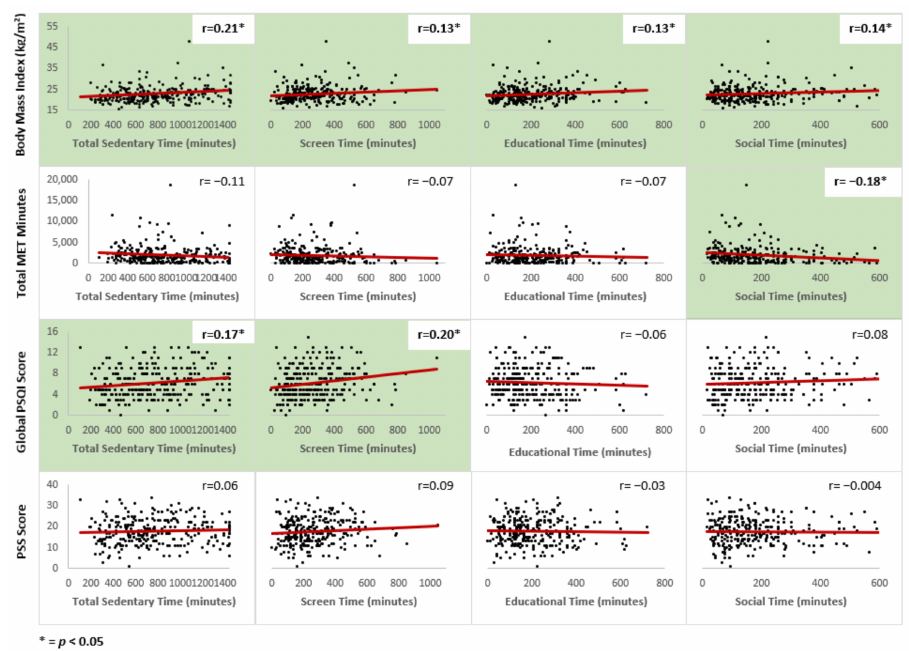
Figure 1. Correlations between sedentary behavior domains and lifestyle